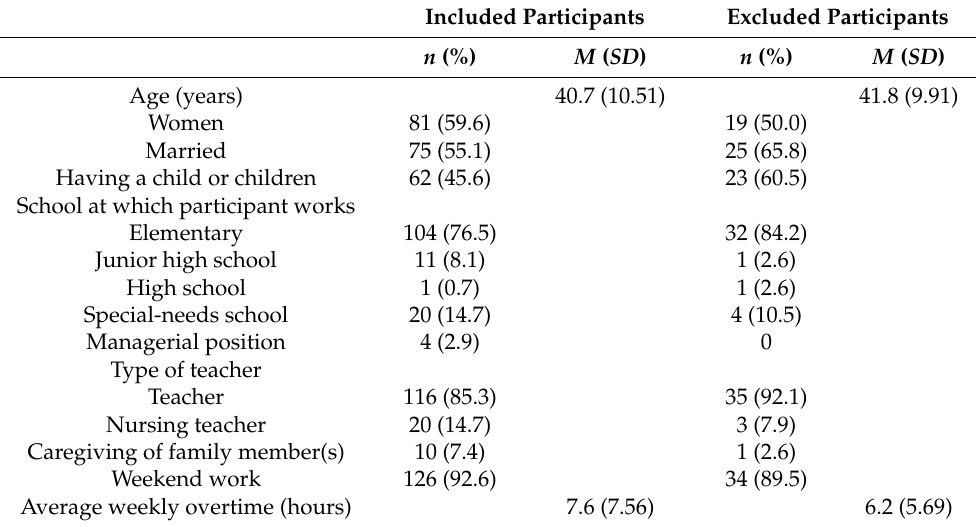
Table 1. Demographic characteristics of participants included in ( n = 136) and excluded from ( n = 38) analysis.